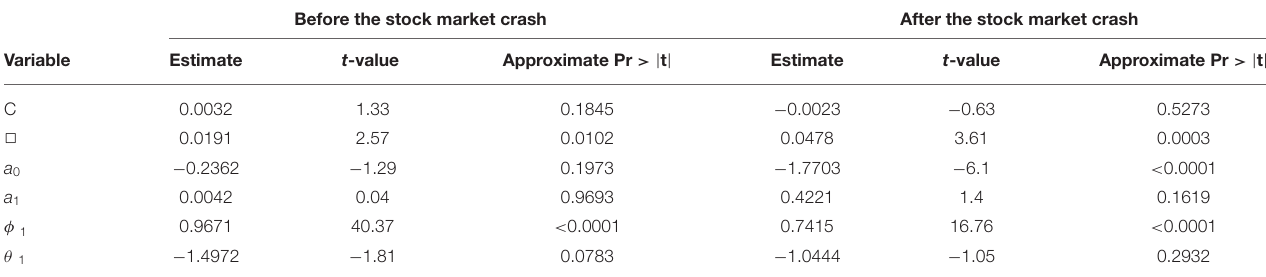
TABLE 11 | Parameter estimation results of the model (11) before and after the stock market crash. Before the stock market